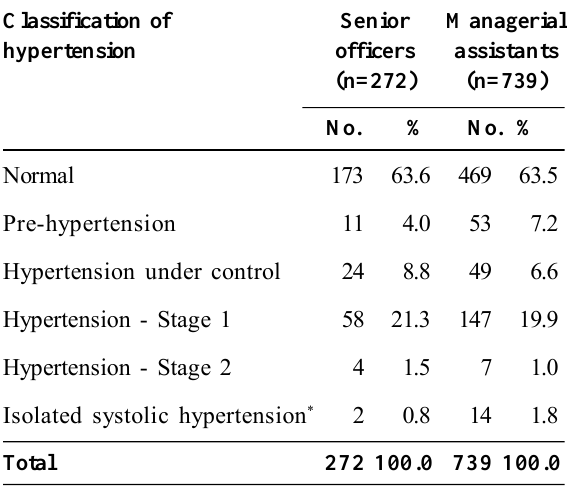
Table 1. Prevalence of hypertension in the